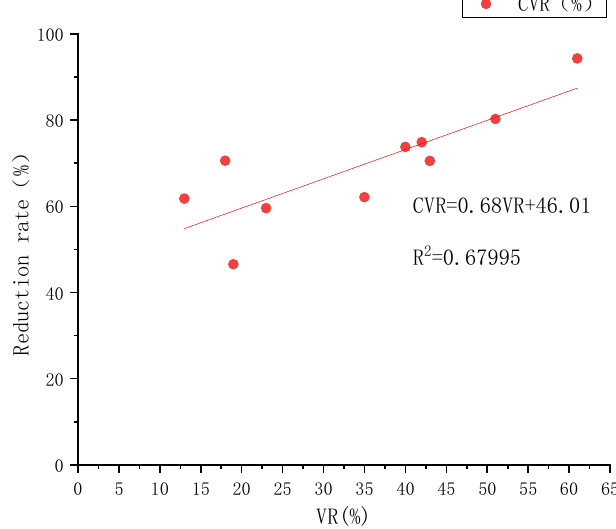
Figure 4. Linear fitting result diagram.